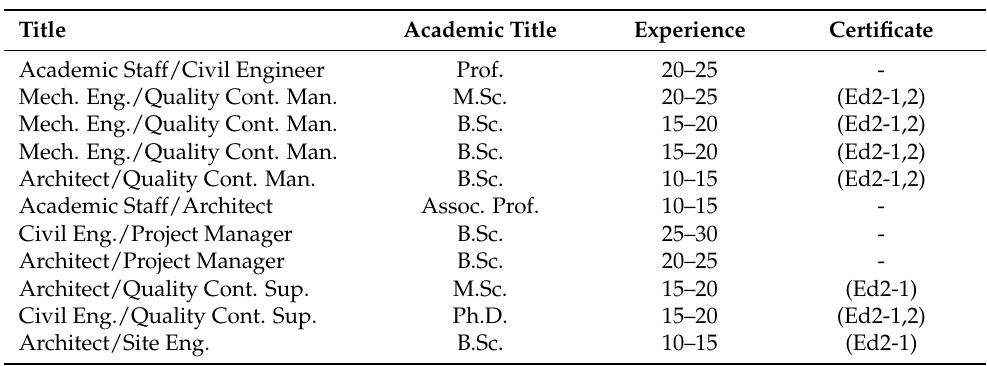
Table 3. Details of panelists